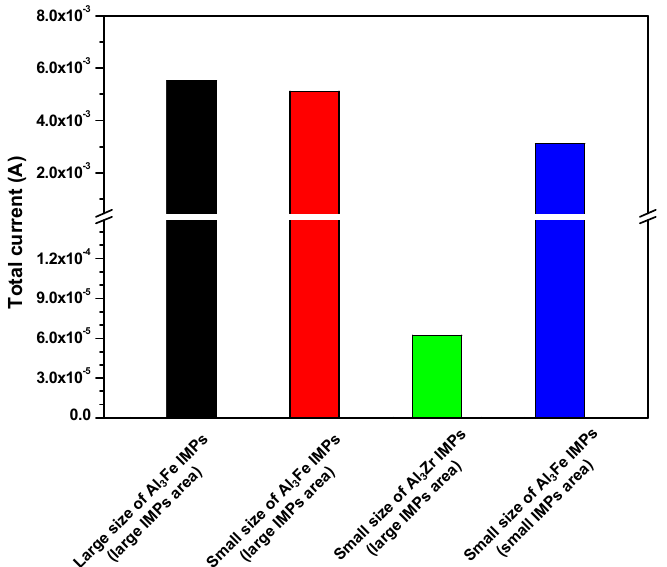
Figure 12. Total current from the Al matrix in each case of corrosion simulations.